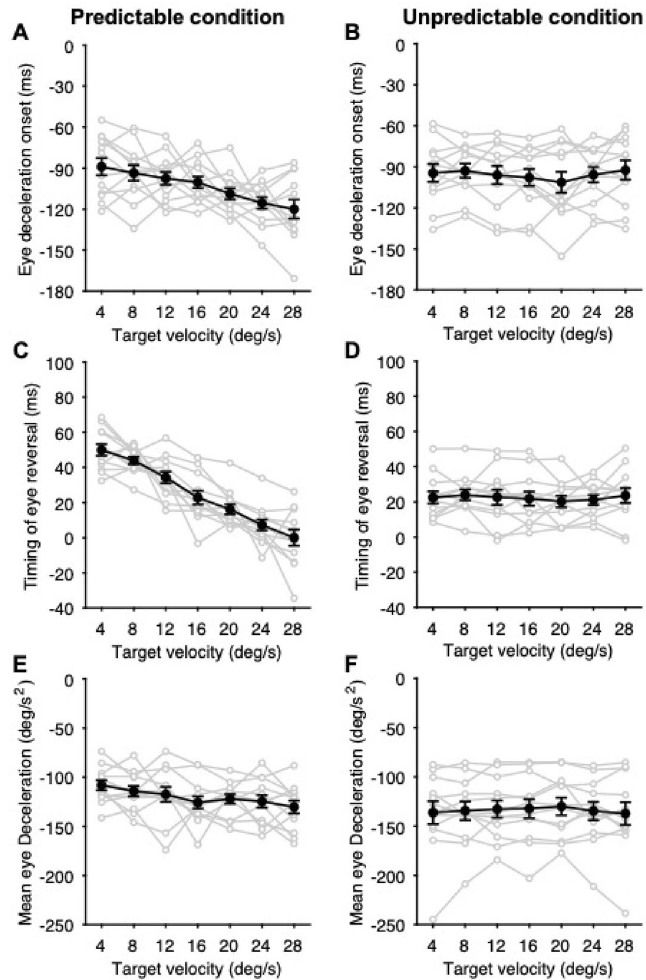
Figure 3. Predictive pursuit responses for the predictable condition (left panels) and unpredictable condition (right panels). ( A , B ) Eye deceleration onset relative to the target reversal as a function of target velocity. ( C , D ) Timing of eye reversal relative to the target reversal as a function of target velocity. ( E,F ) Mean eye deceleration as a function of target velocity. The gray circles and lines represent the values of each observer and black circles and lines represent the mean values of all the observers. Error bars indicate 1